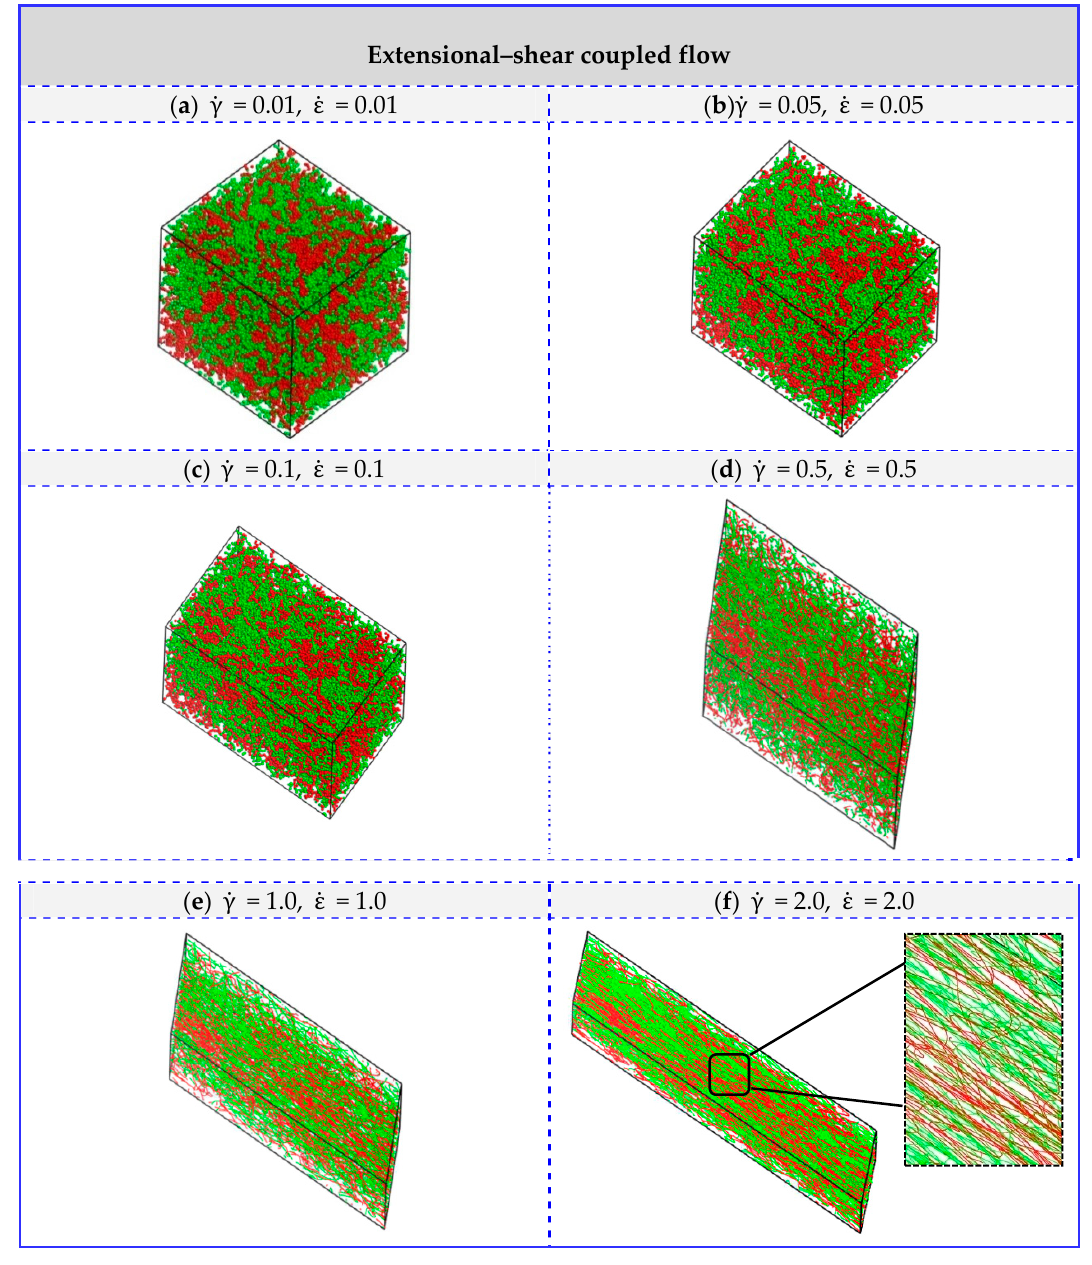
Figure 4. Morphologies of UHMWPE/PA6 blends of 50/50 mass fractions under extensional–shear coupled flow. The red and blue beads represent the PA6 and UHMWPE polymers, respectively. ( e , f ) are displayed in line style and the others are presented in dot-line style.